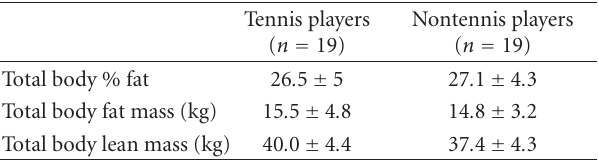
Table 3: Body composition measurements of adolescent tennis players and nontennis players.